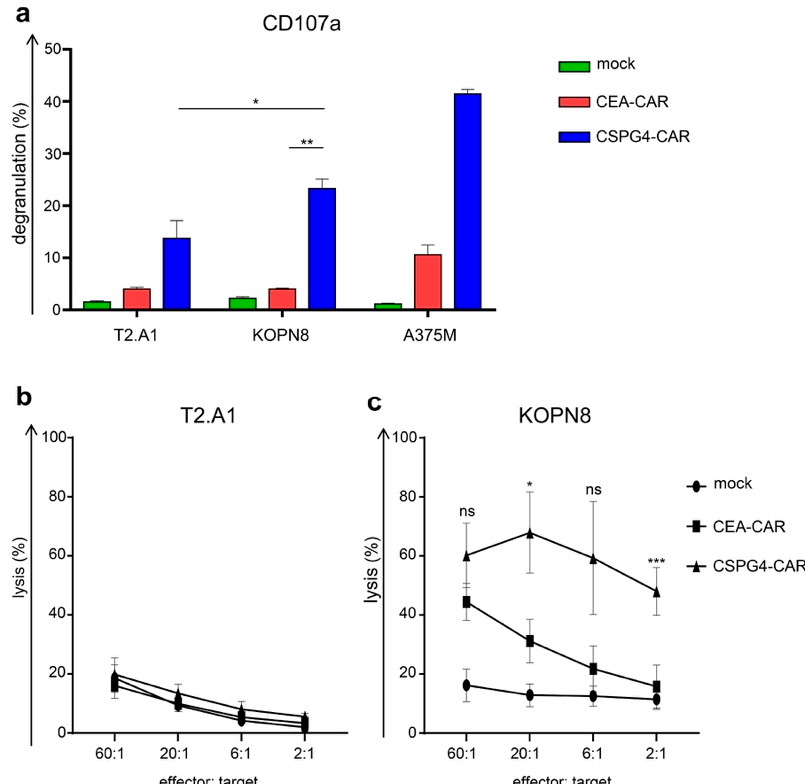
Figure 4. CSPG4-CAR T cells antigen-specifically kill KOPN8 leukemia cells. The di ff erent T cell conditions were generated as mentioned above (Figure 2). Mock (no RNA)-electroporated T cells and CEA-CAR T cells served as negative controls. Cytotoxicity towards T2.A1 cells, KOPN-8 cells, and A375M cells was determined 24 h after electroporation. ( a ) Upon 4 h of co-culture with the target cells, degranulation was assayed using CD107a and CD8 staining. Percent degranulation of CD8 + T cells was calculated by dividing the portion of CD107a-positive / CD8-positive T cells by the portion of CD8-positive T cells. Data represent means ± SEM from three independent experiments; p values were calculated by paired t test, * indicates p ≤ 0.05, and ** indicates p ≤ 0.01. ( b , c ). Lytic capacity towards T2.A1 ( b ) and KOPN8 ( c ) cells was analyzed at the indicated e ff ector-to-target ratios in a standard 4 h chromium lysis assay. Data represent means ± SEM from three independent experiments; p values were calculated by paired t test, * indicates p ≤ 0.05, ** indicates p ≤ 0.01, and *** indicates p ≤ 0.001.